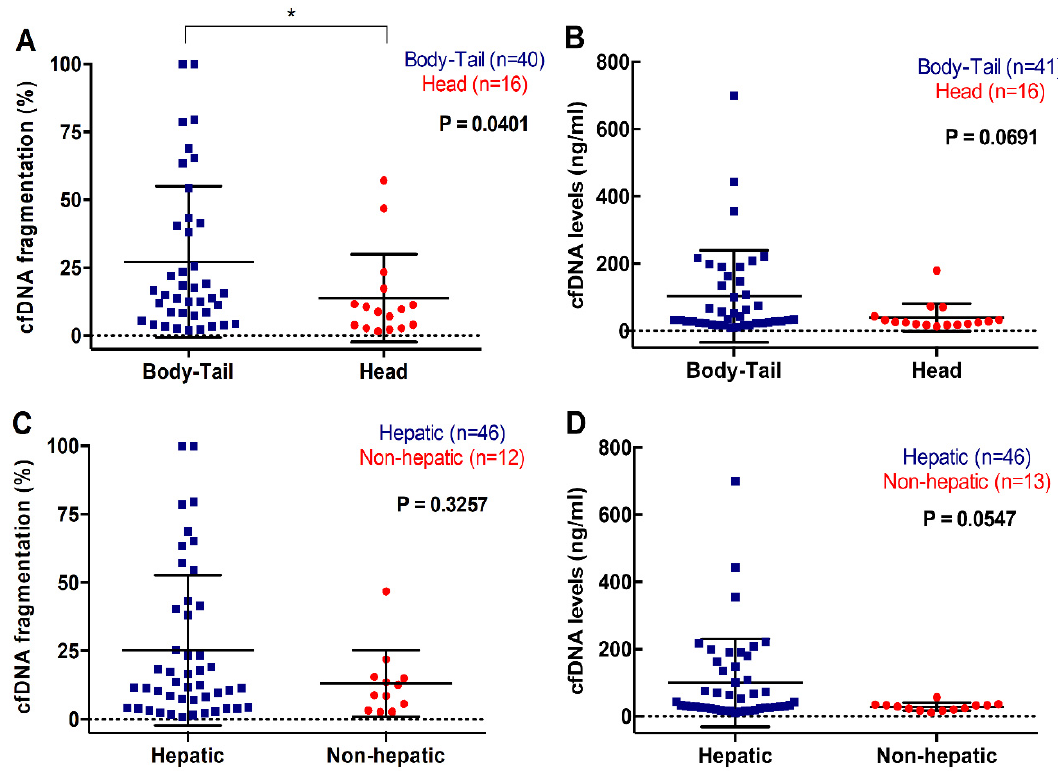
Figure 6. Association between cfDNA concentration and fragmentation and primary tumor and metastasis location. ( A ) cfDNA fragmentation; and ( B ) cfDNA levels according to primary tumor location; ( C ) cfDNA fragmentation; and ( D ) cfDNA levels according to metastatic location (* p < 0.05).